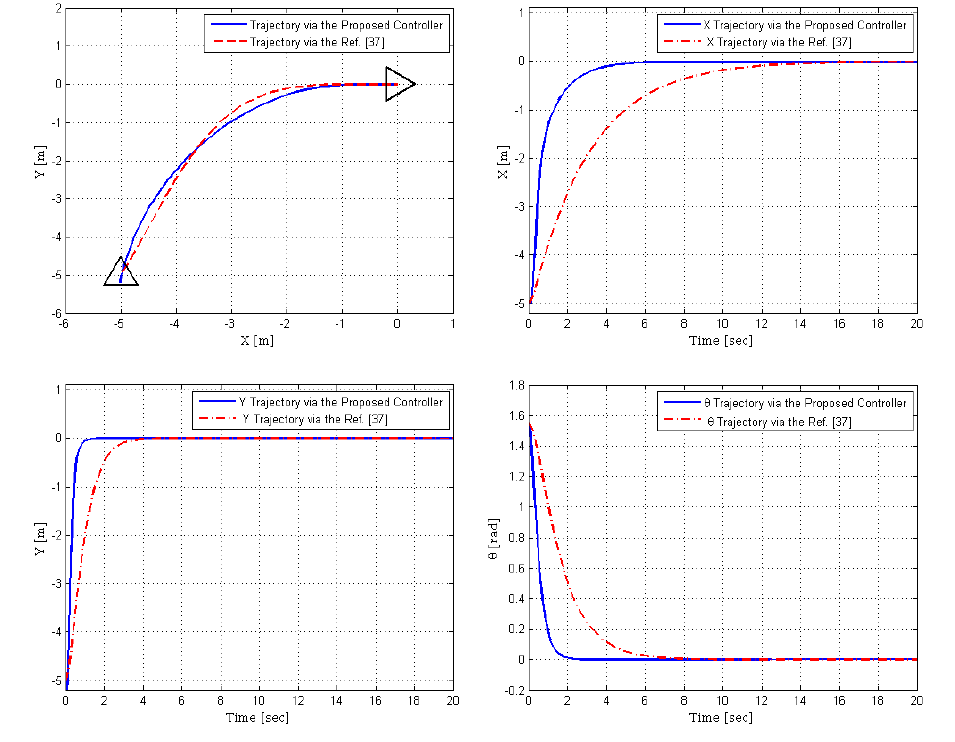
Figure 7. Posture stabilization (forward parking with initial heading angle at 90 ◦ ).